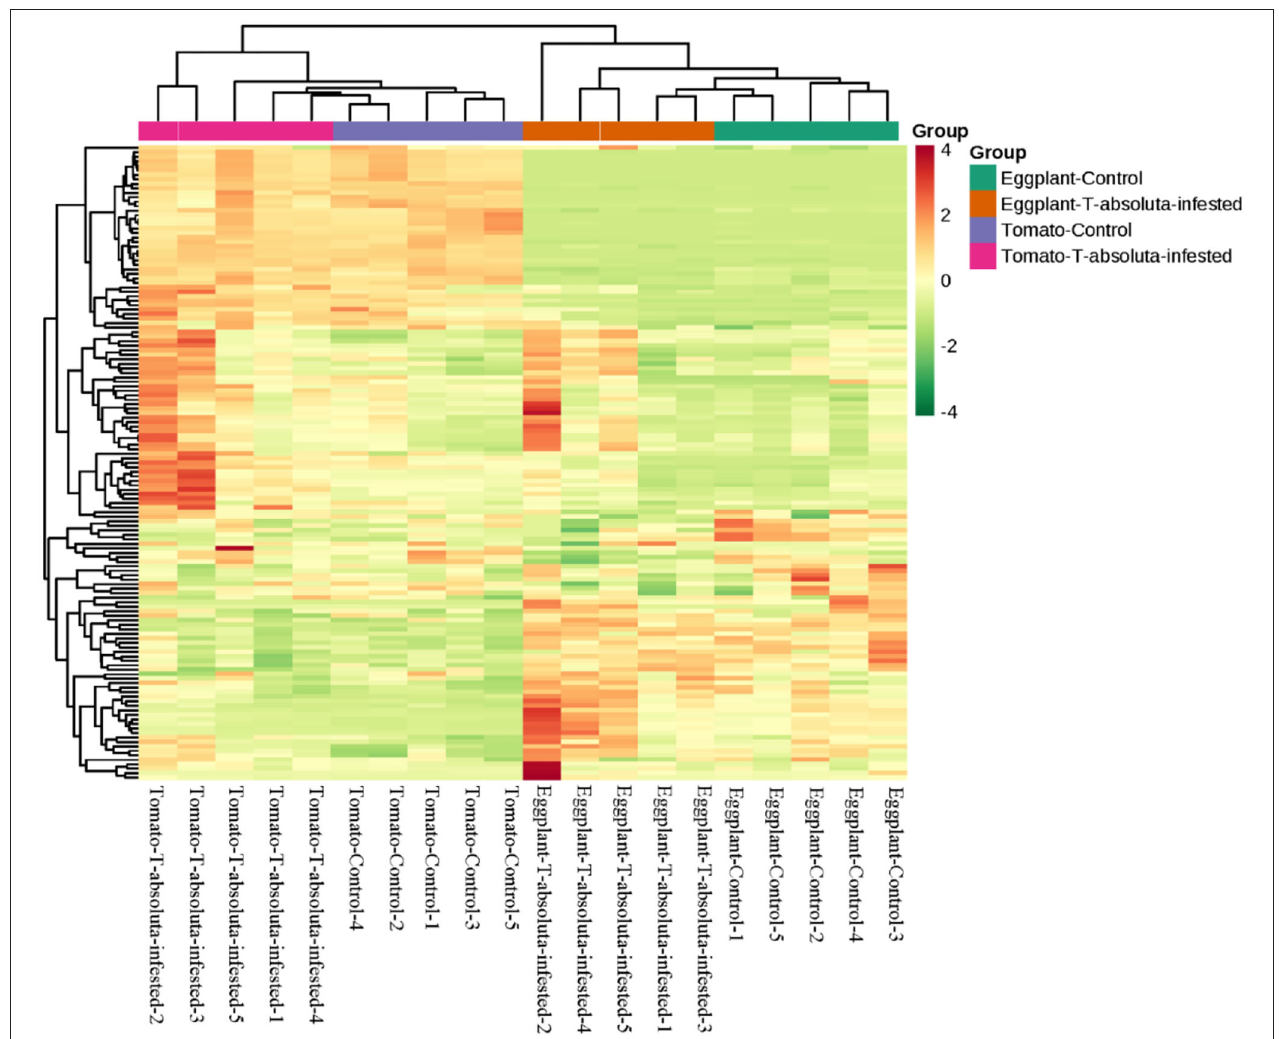
FIGURE 3 | Hierarchical clustering based on the ion intensity of volatile organic compounds from leaves of tomato and eggplant. All analyses were done in quintuplicate: Eggplant-Control (1–5), Eggplant- T. absoluta infested (1–5), Tomato-Control (1–5), and Tomato- T. absoluta infested